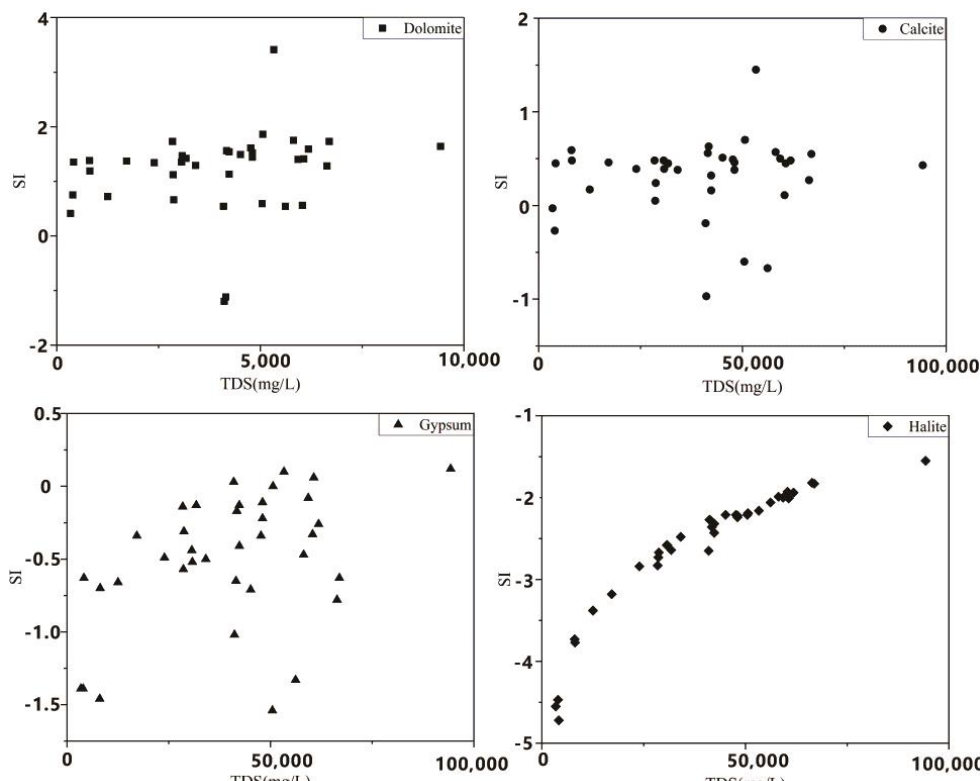
Figure 8. Relations between saturation indices and TDS of the four minerals. Water 2022 , 14 , 3247